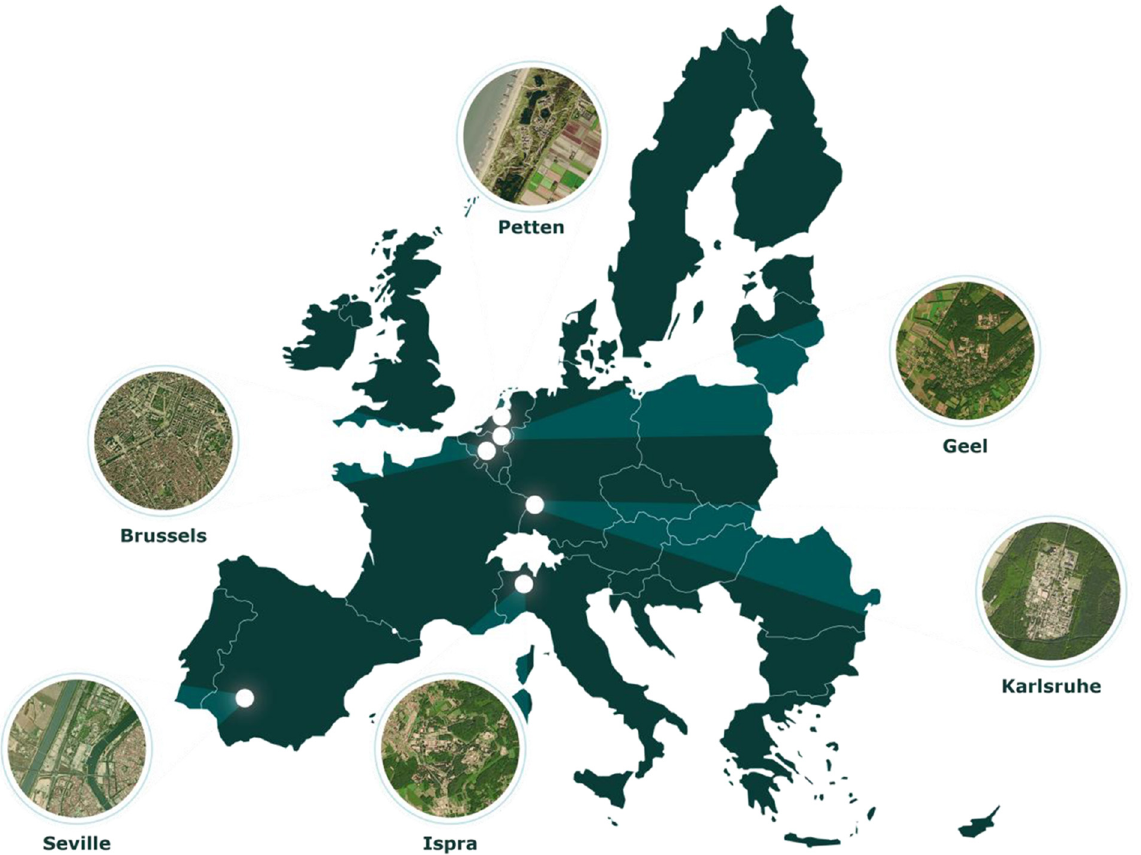
Fig. 1. European Commission ’ s Joint Research Centre